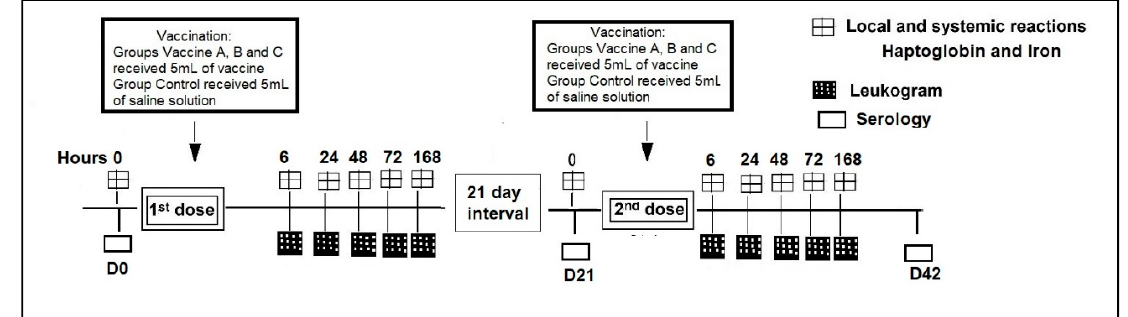
Figure 1. Timeline of experimental design.